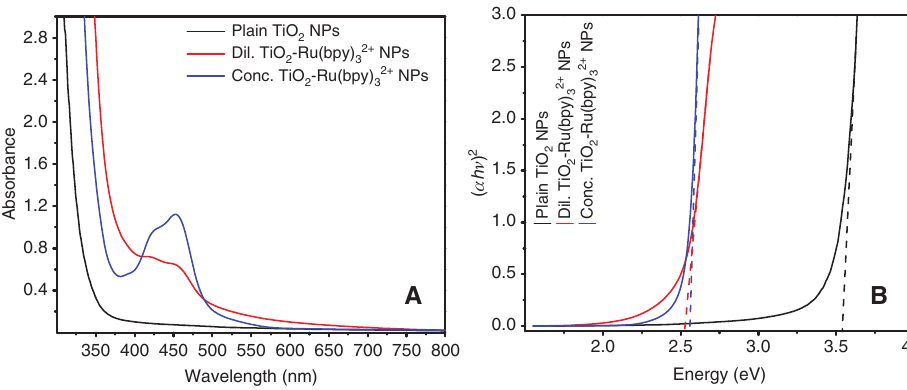
, diluted TiO -Ru(bpy) 32 + and concentrated TiO 2 2 -Ru(bpy) 32 + NPs. 2